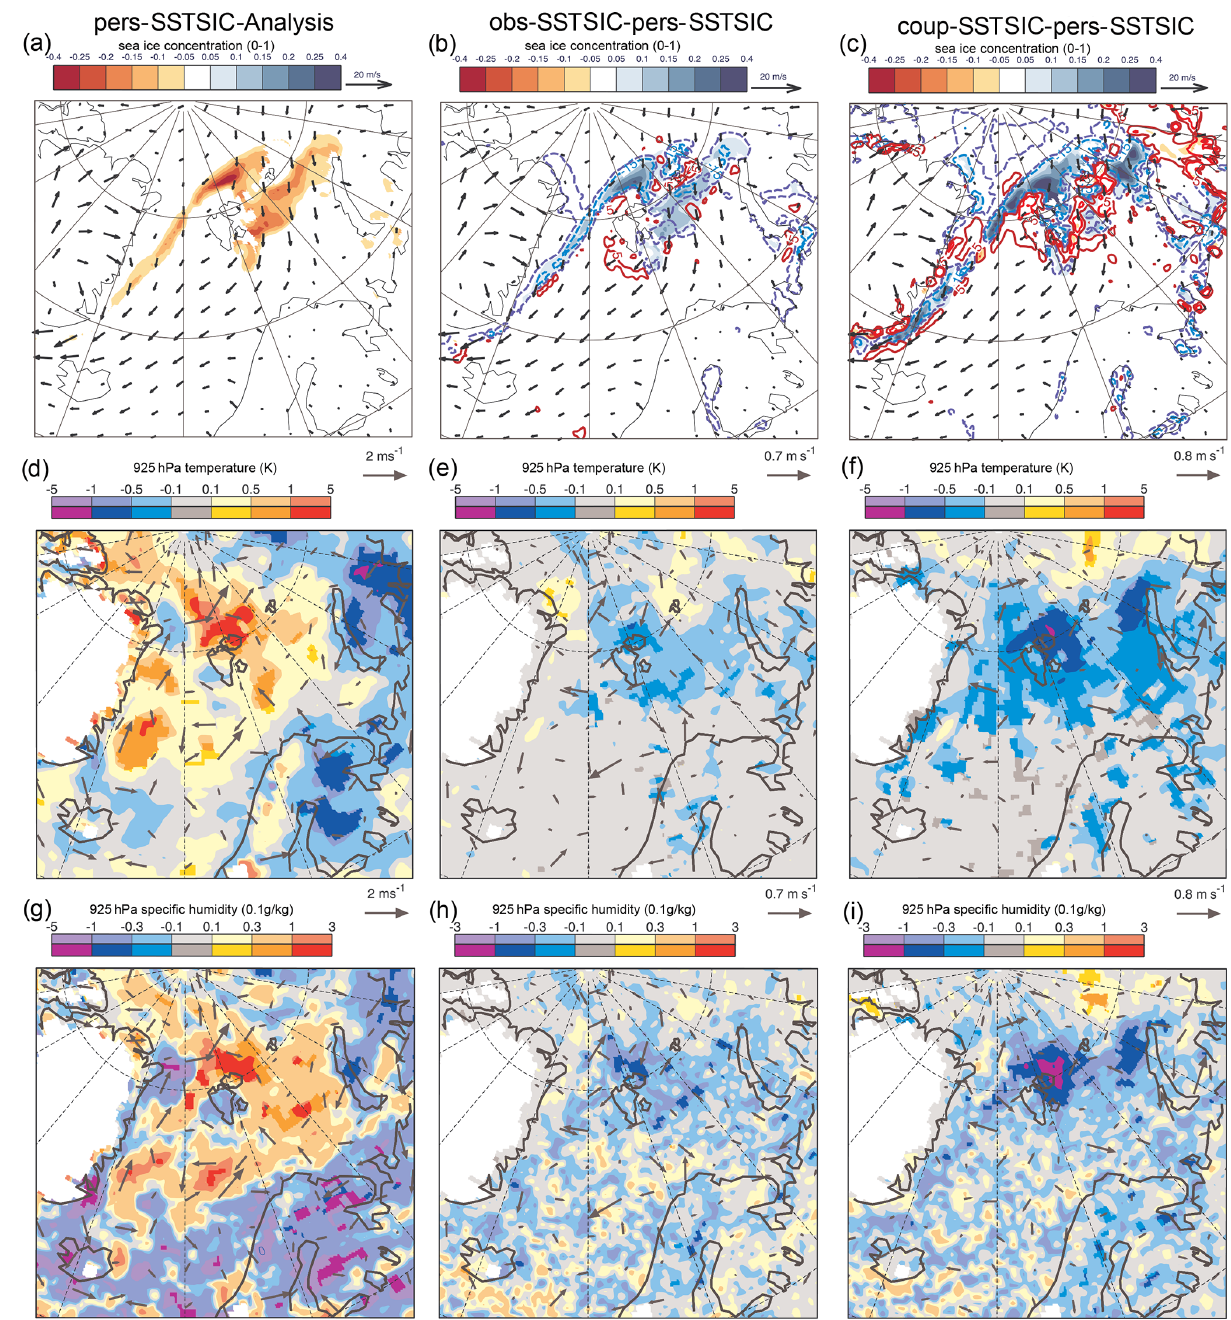
Figure 9. Composite of forecast error during periods of ice advance in the Nordic Seas: day-3 sea ice concentration bias along with composite- mean winds at 925hPa (a) , T + 72 925hPa temperature and horizontal wind bias (d) , and specific humidity and horizontal wind bias (g) for the pers-SSTSIC forecasts and the change in the bias for obs-SSTSIC ( b , e and h ) and coup-SSTSIC ( c , f and i ) with respect to the pers-SSTSIC forecasts. The change in the turbulent heat flux (sensible + latent accumulated between T + 48 and T + 72) is shown in the blue and red contours in (b) and (c) (anomalies are positive downwards). In panels (d–i) , saturated colours indicate mean differences that are statistically significant at the 5%